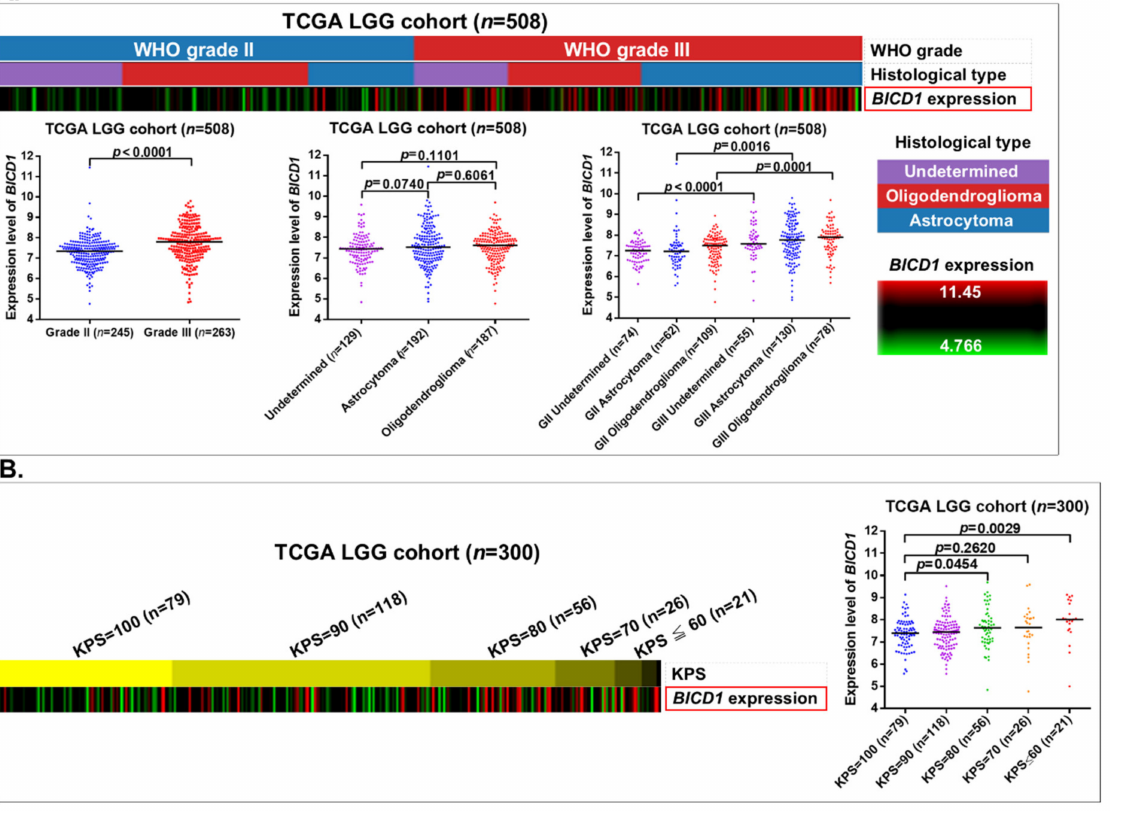
Figure 3. The correlations of BICD1 downregulation with the WHO grade, histological subtypes, and the KPS of LGG patients. ( A ). The heatmap and the t -test analyses revealed the correlations of BICD1 downregulation with the WHO grade and the histological subtypes of LGGs in the TCGA LGG cohort. ( B ). The heatmap and the t -test analysis revealed the correlations between the expression levels of BICD1 and the KPS of patients in the TCGA LGG